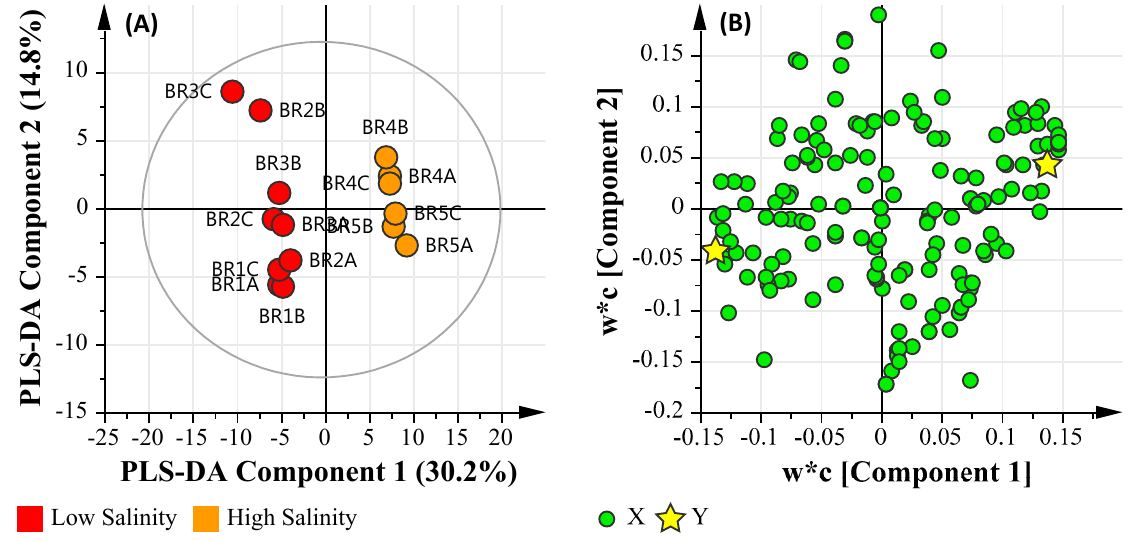
Figure 7. PLS-DA plot of the metadata and multi-omics datasets based the Microbial Water Quality Assessment Category class assessment. ( A ) PLS-DA Score Scatter plot; ( B ) PLS-DA Loading Scatter plot.